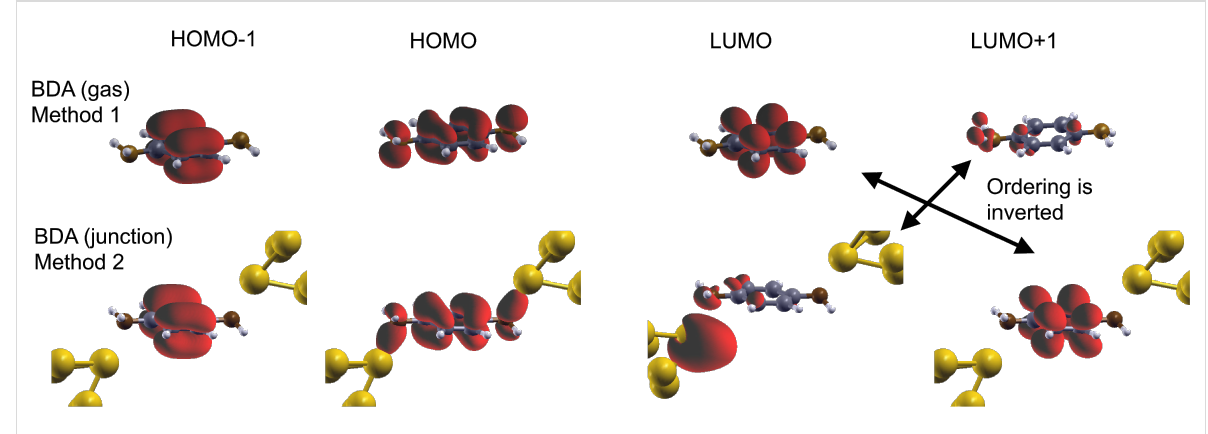
Figure 1: Electronic density isosurfaces (red) of the HOMO − 1, HOMO, LUMO and LUMO+1 molecular orbitals of BDA as obtained with the two tradi- tional methods (see text). The ordering of the LUMO and LUMO+1 is inverted in the two methods. The localized MOs (HOMO − 1 and LUMO (gas) or LUMO+1 (junction)) look remarkably similar for both methods. In contrast, the HOMO and LUMO in the junction present a clear bonding with the leads and thus slightly differ from the corresponding MOs in gas phase. Hydrogen, carbon and sulfur atoms are represented by white, grey and green spheres,